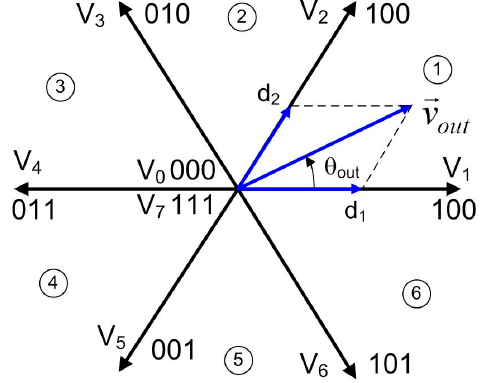
Figure 3. The space vector diagram of inverter stage.